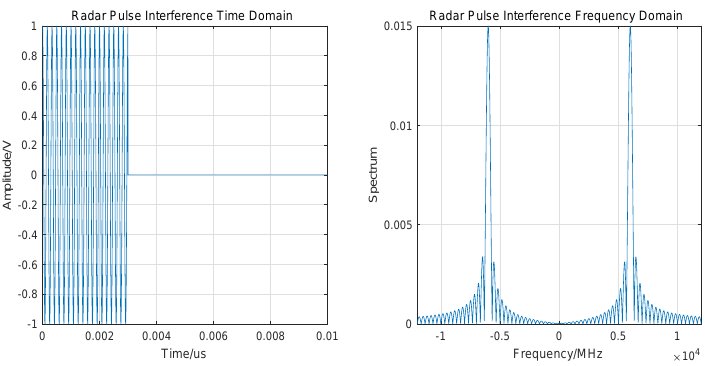
Figure 6. RP interference time–frequency domain